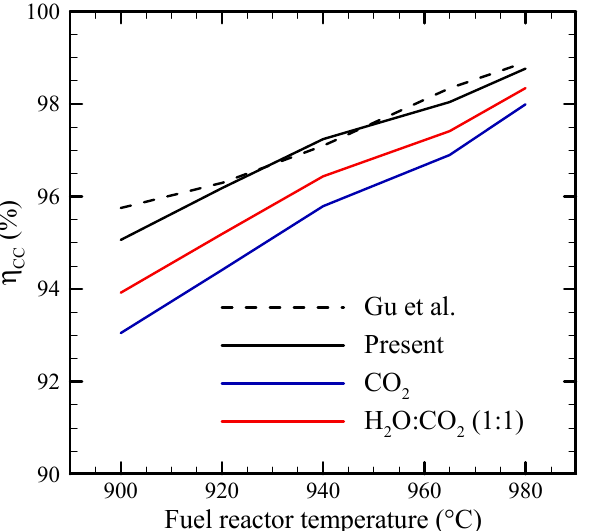
Figure 7. Performance of carbon capture as a feature of the gasification agents (i.e., steam and CO 2 ).